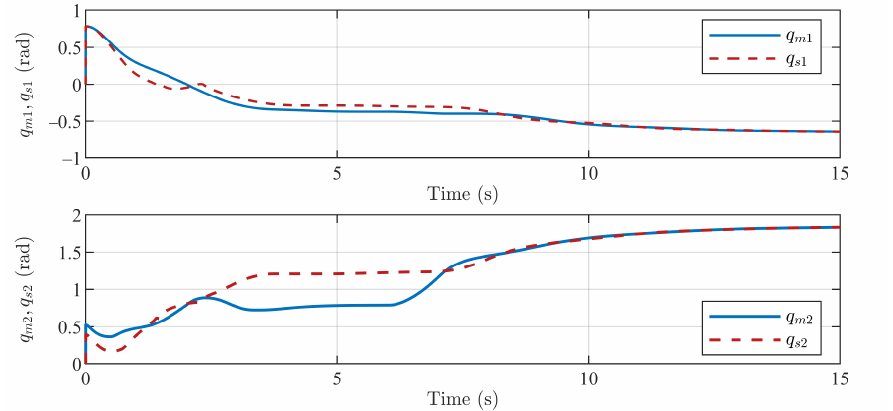
Figure 16. Joint positions with the method in Case 3.